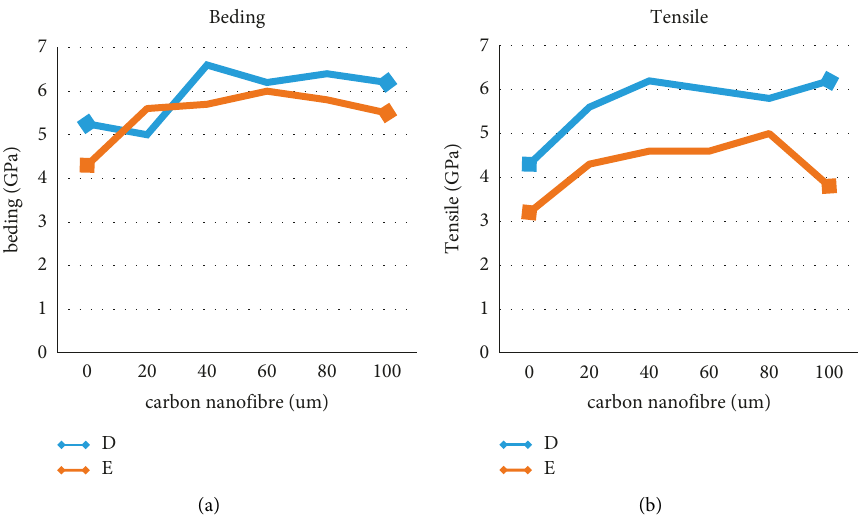
Figure 12: Comparison of flexural modulus (a) and compressive modulus (b).